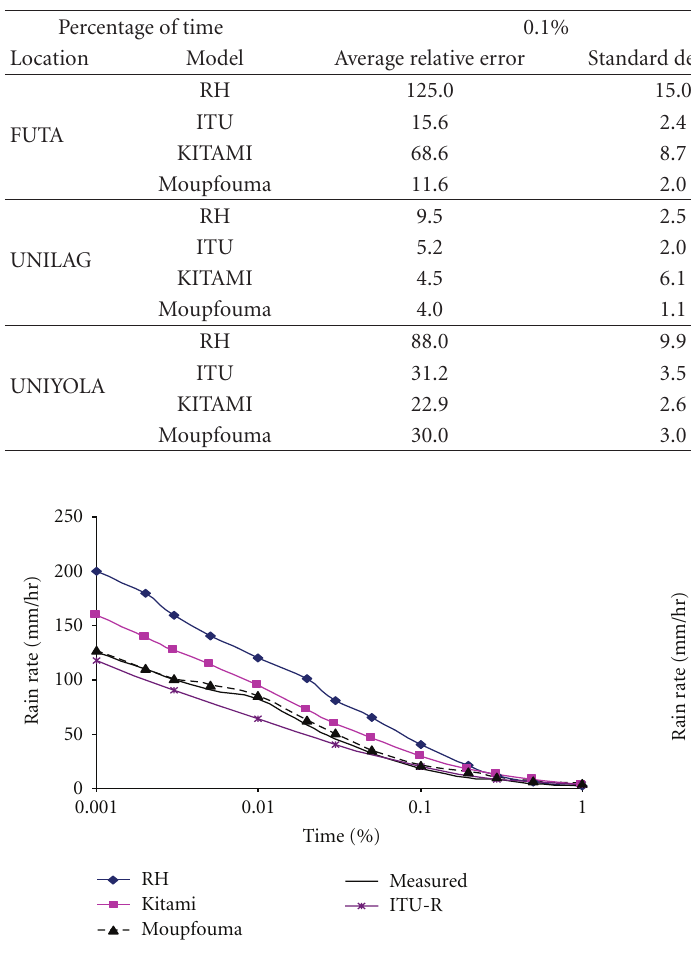
Figure 2: Comparison of measured FUTA rainfall data with model predictions.